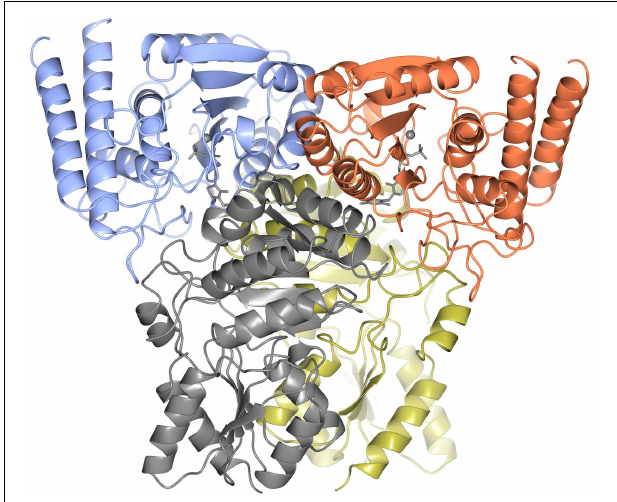
FIGURE 6 | The overall structure of ChTK-F heterotetramer is shown as a cartoon model with the ChTK-N monomers shown in blue and red and the ChTK-C monomers shown in gray and gold with the Ca 2 + and TPP cofactor shown as stick models in